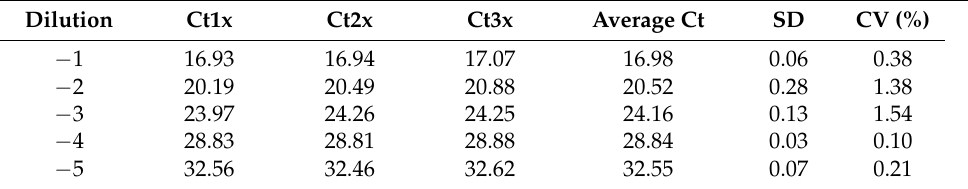
Table 1. Reproducibility of the real-time PCR method for the invA gene.